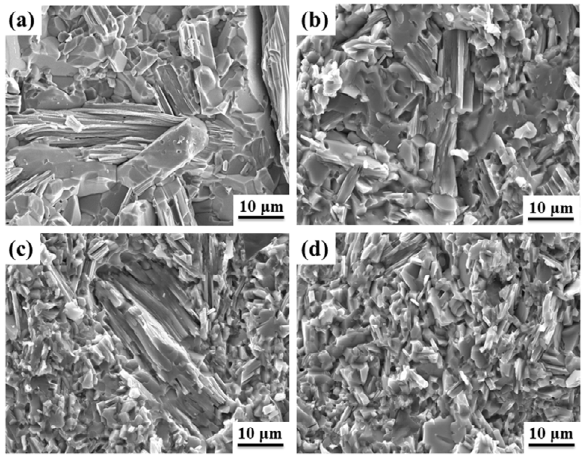
Fig. 6 SEM images for the fractured surfaces of SiC w /Ti 3 SiC 2 containing different amount of SiC w after SPS at 1350 ℃ : (a) 0 wt%, (b) 1 wt%, (c) 5 wt%, and (d) 10 wt%.